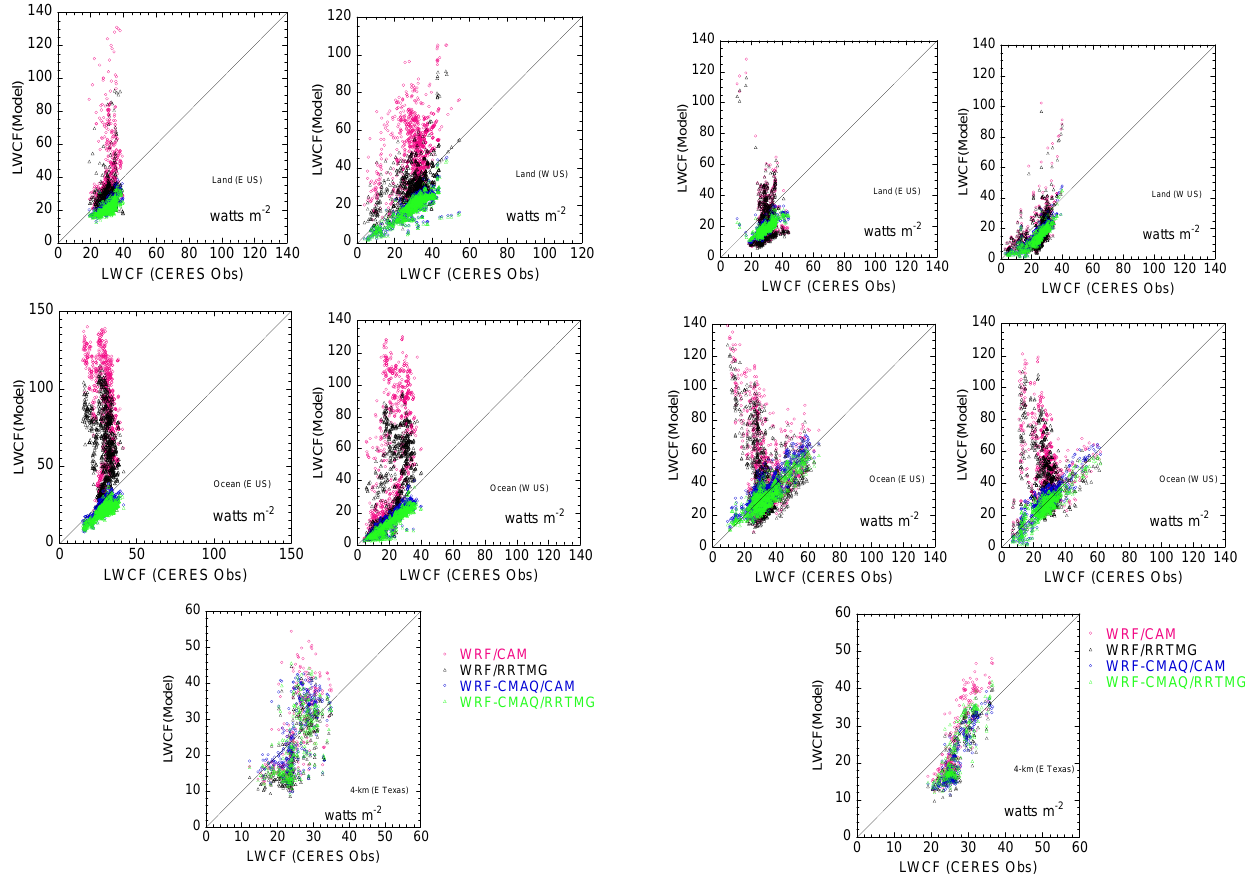
Figure 16. Same as Fig. 15, but for September of 2006. close. The NMB values for SWCF (LWCF) over the land of the EUS in August of 2006 are − 11.74 % ( − 27.86 %) and − 22.45 % ( − 30.76 %) for WRF–CMAQ/CAM and WRF– CMAQ/RRTMG, respectively, whereas over the land of the WUS, they are − 25.82 % ( − 34.15 %) and − 33.40 % ( − 35.45 %), respectively. The consistent underestimations of SWCF and LWCF by both WRF–CMAQ/CAM and WRF– CMAQ/RRTMG indicate that the WRF–CMAQ